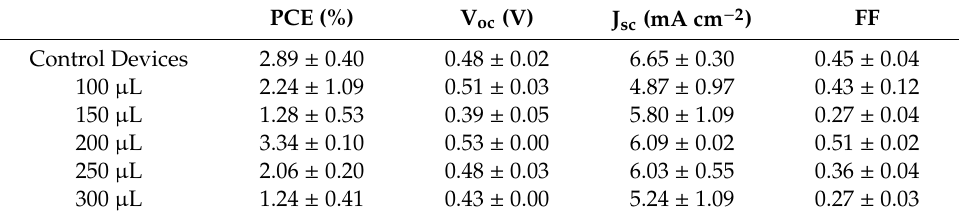
Figure 5. ( a ) J / V curves for the best performing device with and without a DAD interlayer; ( b ) J / V properties for devices with DAD interlayers spun from different solution volumes after an aqueous AuCl 3 treatment. Table 1. Device properties of gold chloride doped devices at different DAD volumes vs devices with no interlayer.